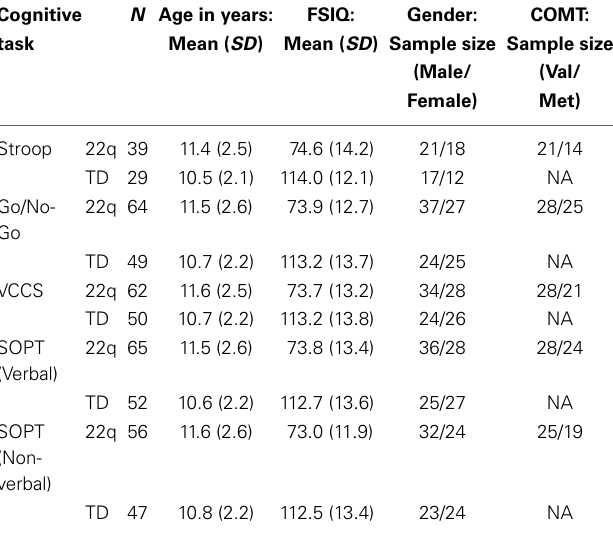
Table 1 | Demographic data on children with 22q11.2DS (22q) and TD